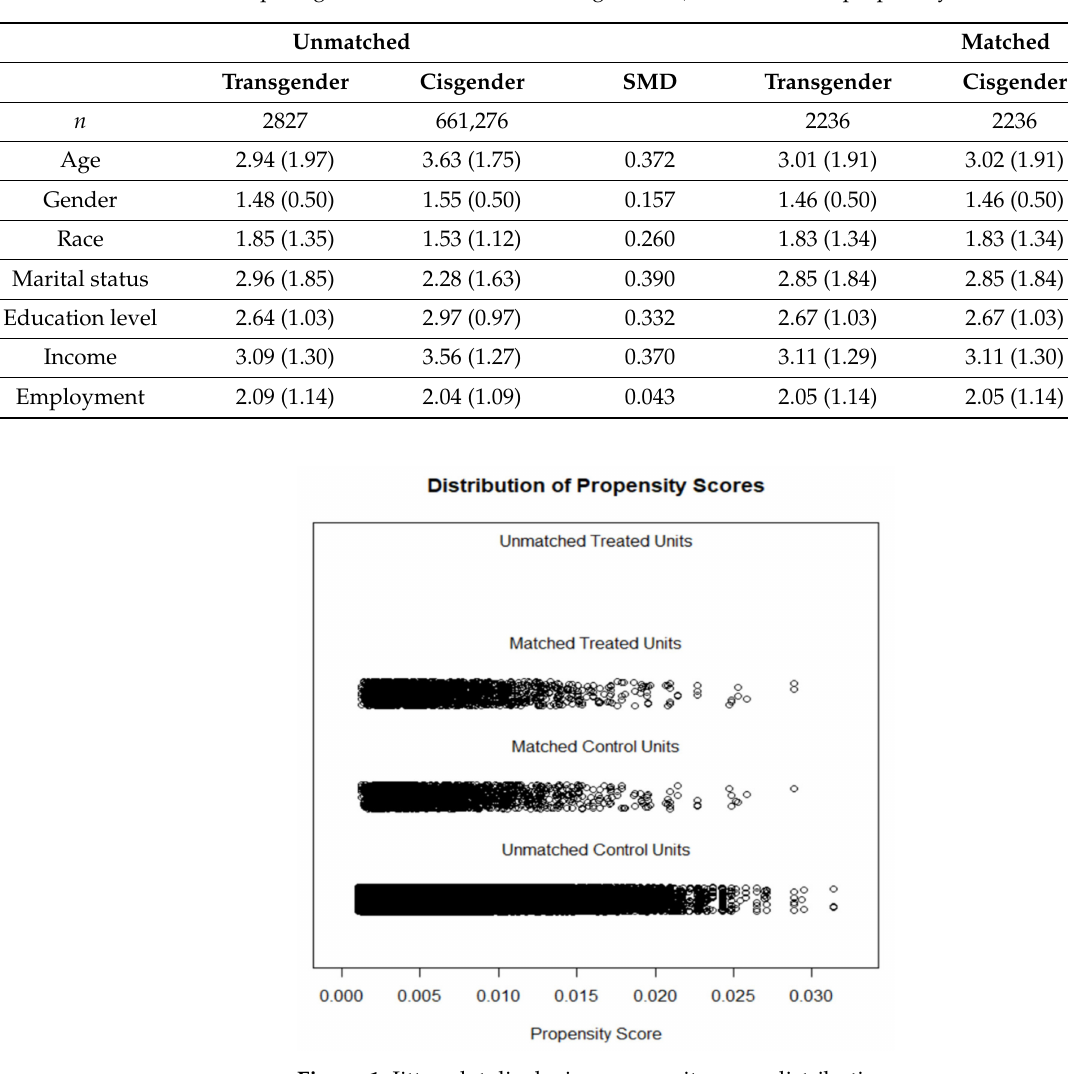
Table 2. Comparing the covariates’ balance diagnostics (effectiveness of propensity score matching).